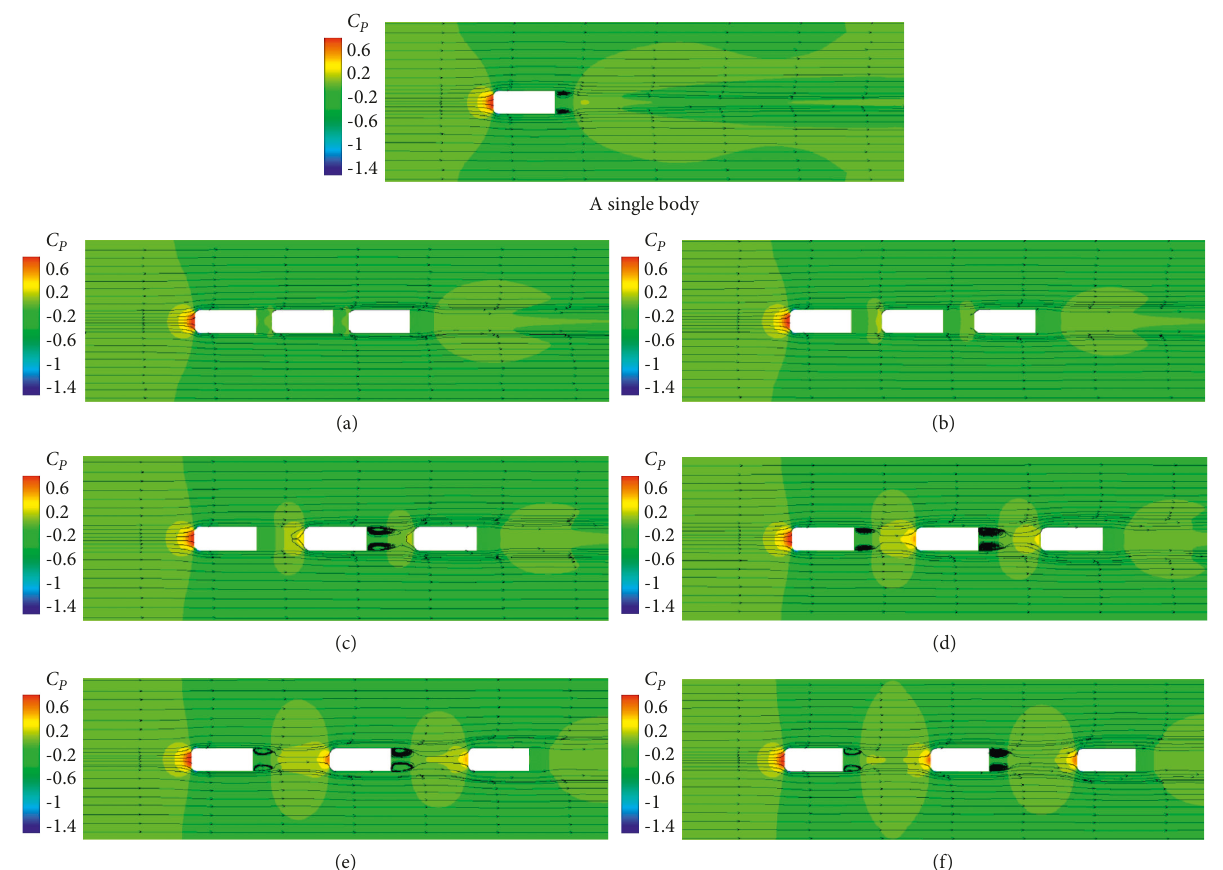
Figure 16: The pressure contour and streamline distribution of a single body and three bodies in the platoon on the z/(L) � 0.08 plane. (a) x/L � 0.25 (b) x/L � 0.5. (c) x/L � 0.75. (d) x/L � 1. (e) x/L � 1.25. (f) x/L �